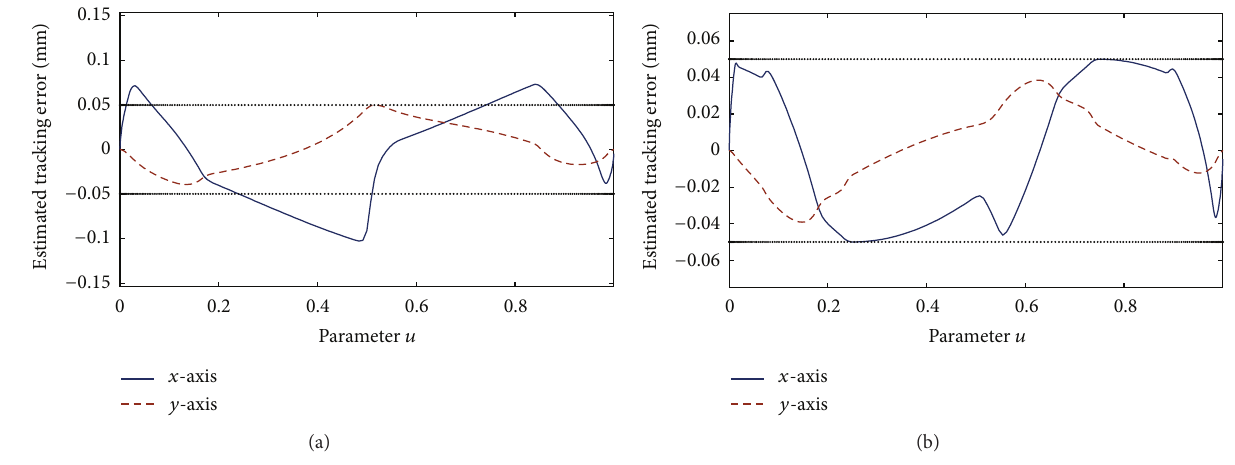
Figure 8: Tracking error trajectories of the (a) SMTT and (b) TEC-SMTT. Table 1: Performance comparison among MTT, SMTT, TEC-SMMT, and RTEC-SMTT for the ellipse path.